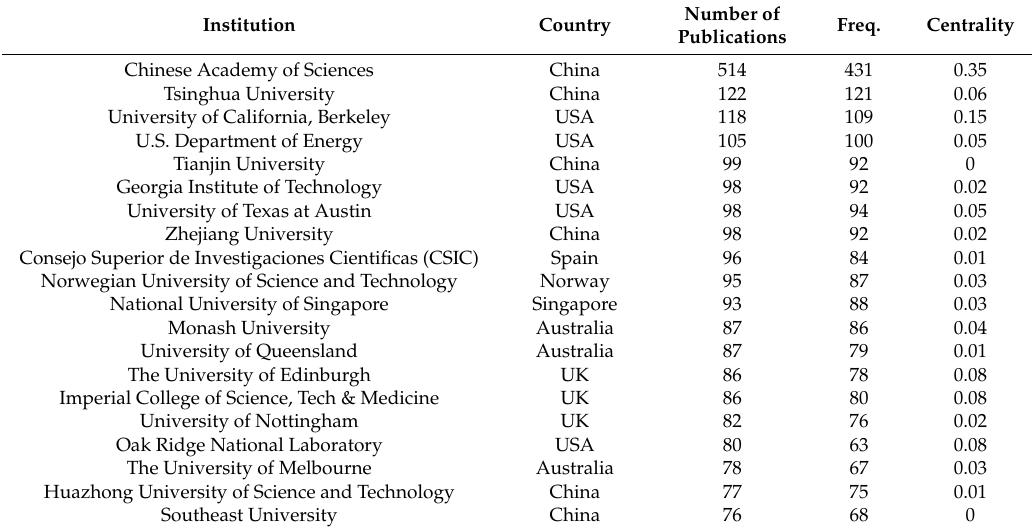
Table 2. Top 20 most productive institutions in the CCS research